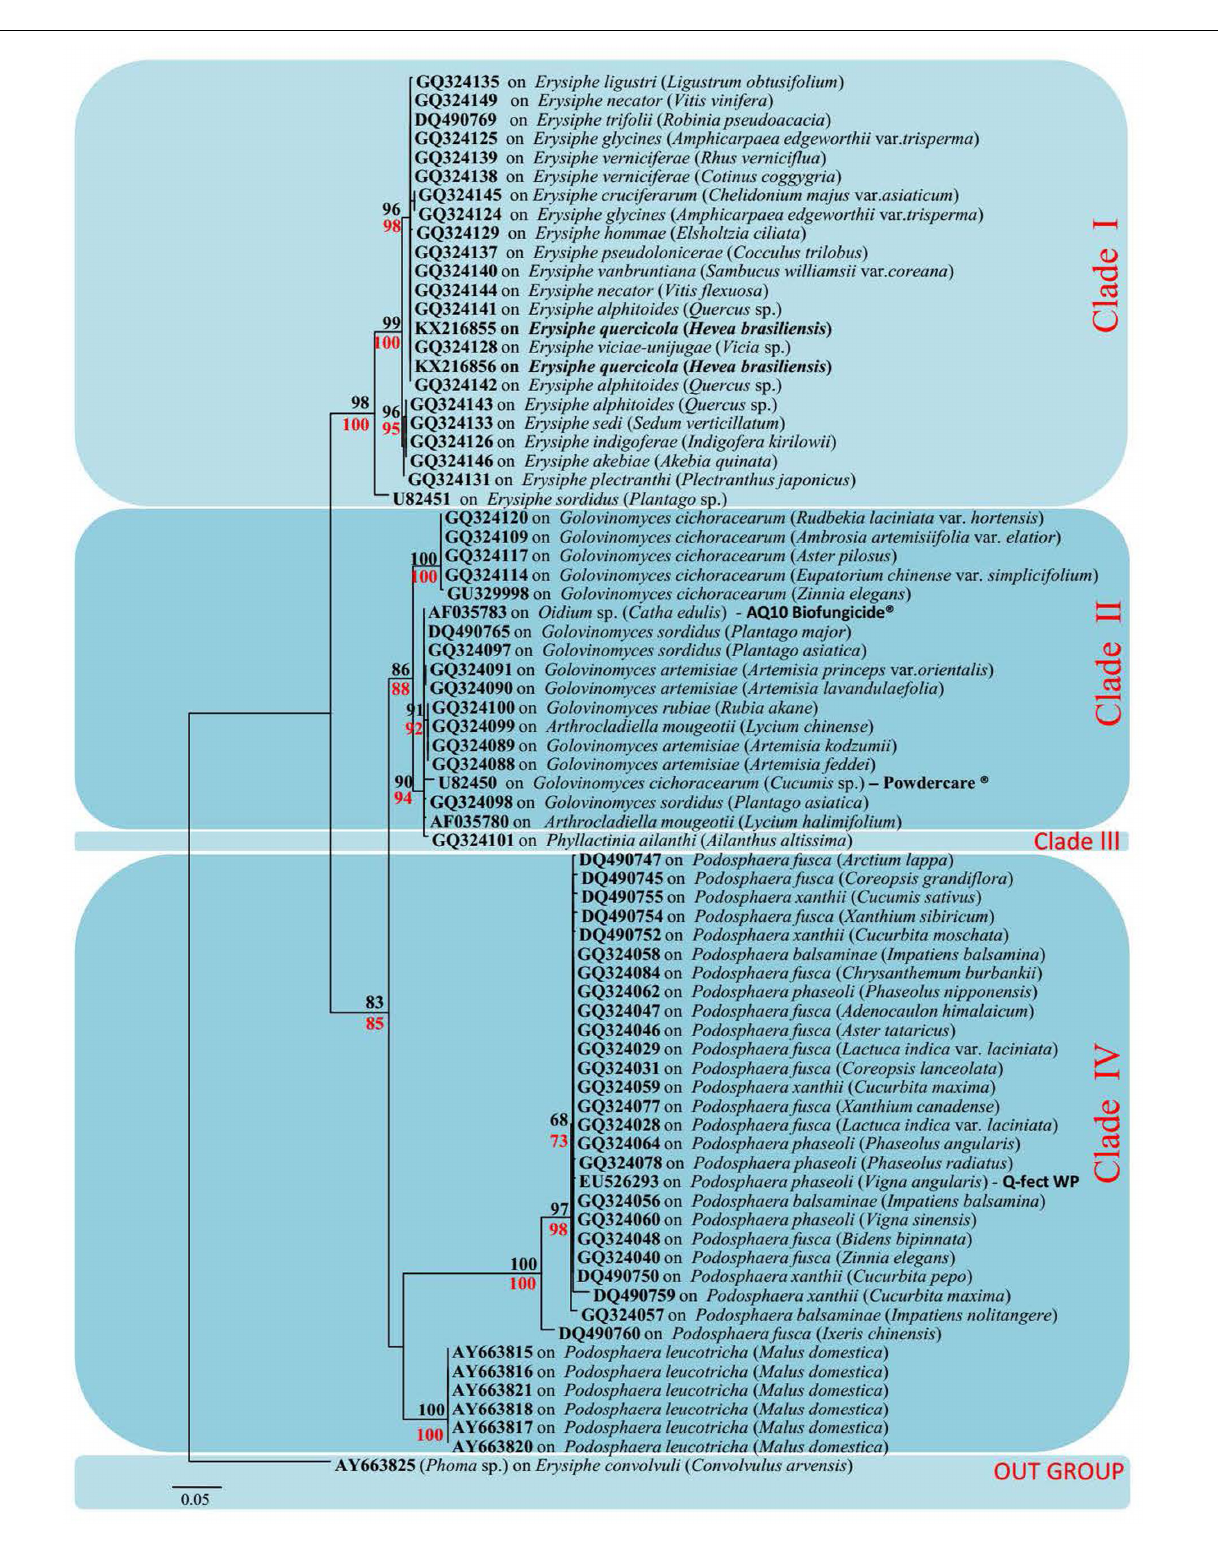
Frontiers in Microbiology |